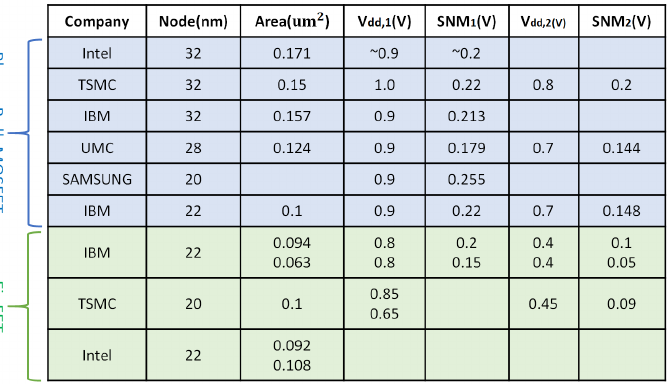
Figure 2. State-of-the-art SRAM